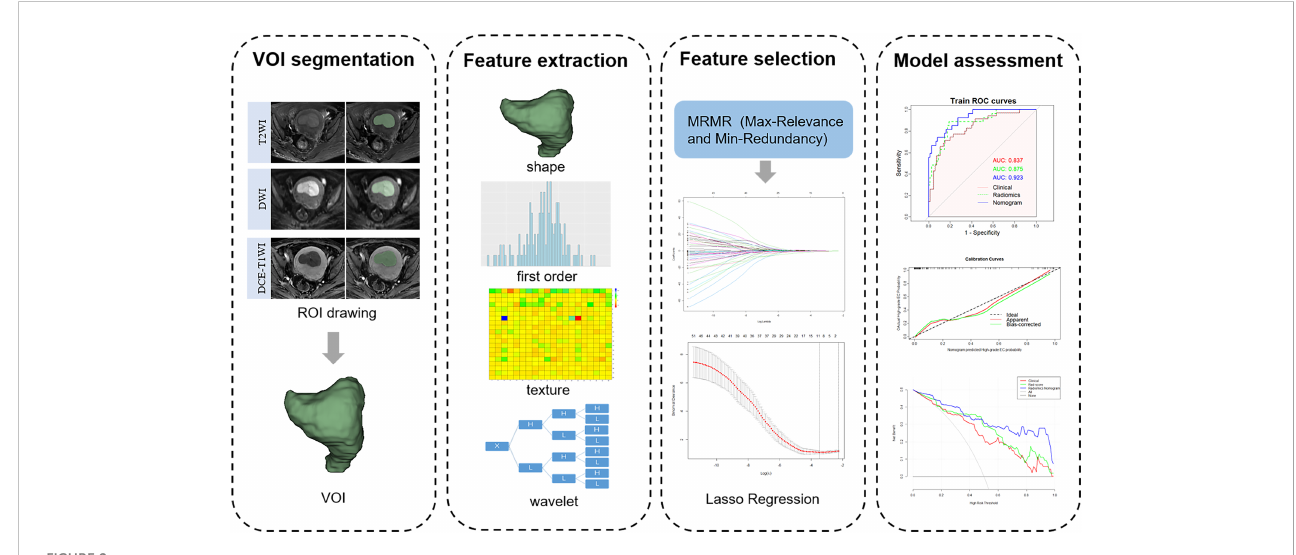
FIGURE 2 Work fl ow of radiomics analysis and model building.